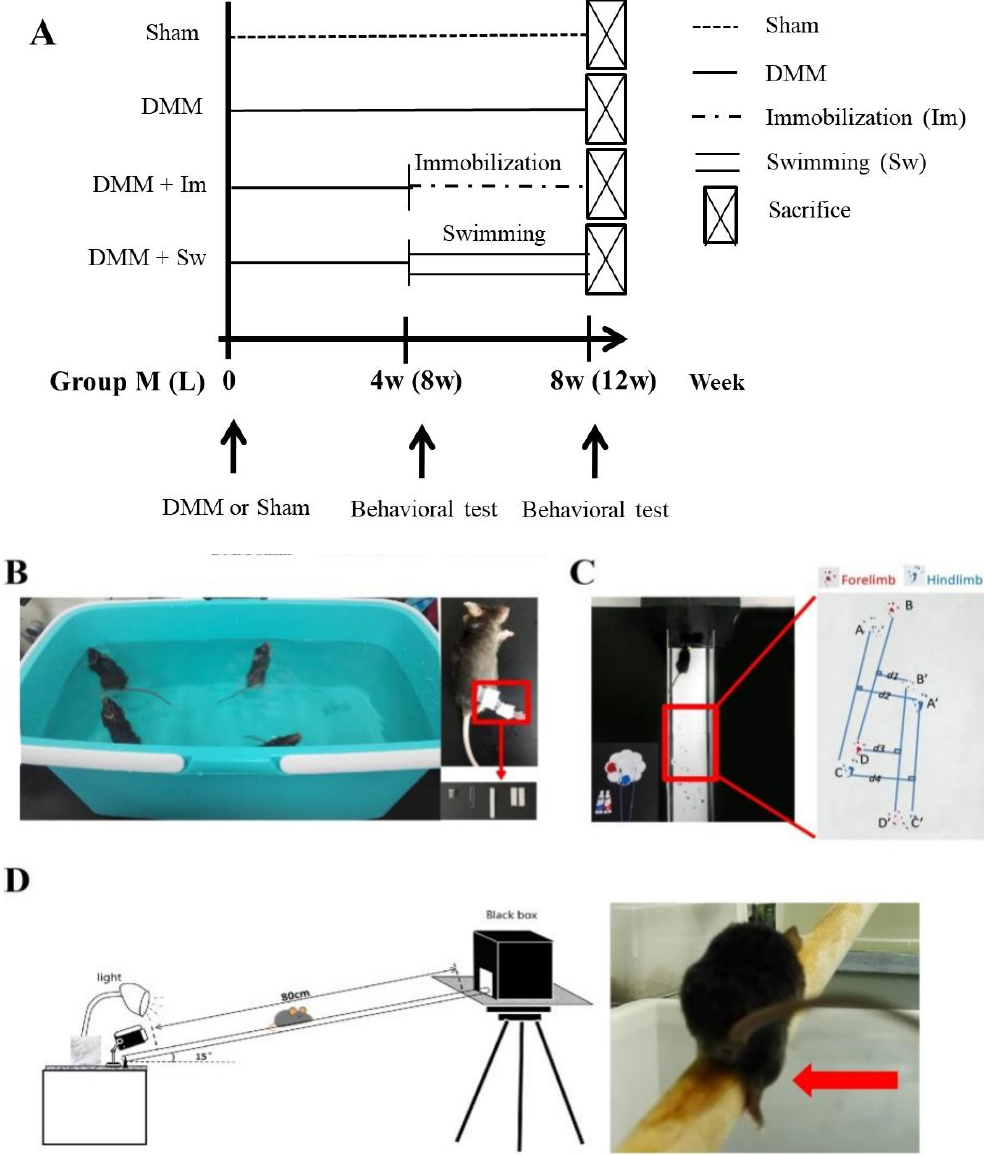
Figure 7. Diagrams and photos of mice grouping and experimental methods. ( A ) Diagram of mice grouping. ( B ) Swimming and immobilization treatment. ( C ) Photo of ink blot test and the footprints of the mice; their front paws were dyed with red ink and the hind paws with blue ink. ( D ) Diagram of beam walking test. The red arrow shows the moment of mice falling off the beam. Group M: middle stage of OA, 4 weeks after DMM and Group L: late stage of OA, 8 weeks after DMM. DMM, destabilization of the medial meniscus.